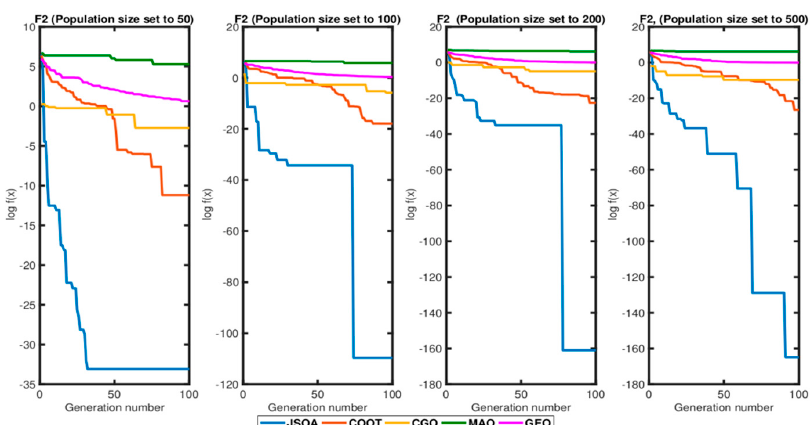
Figure 8. JSOA, COOT, CGO, MAO, and GEO Convergence graph population size analysis.